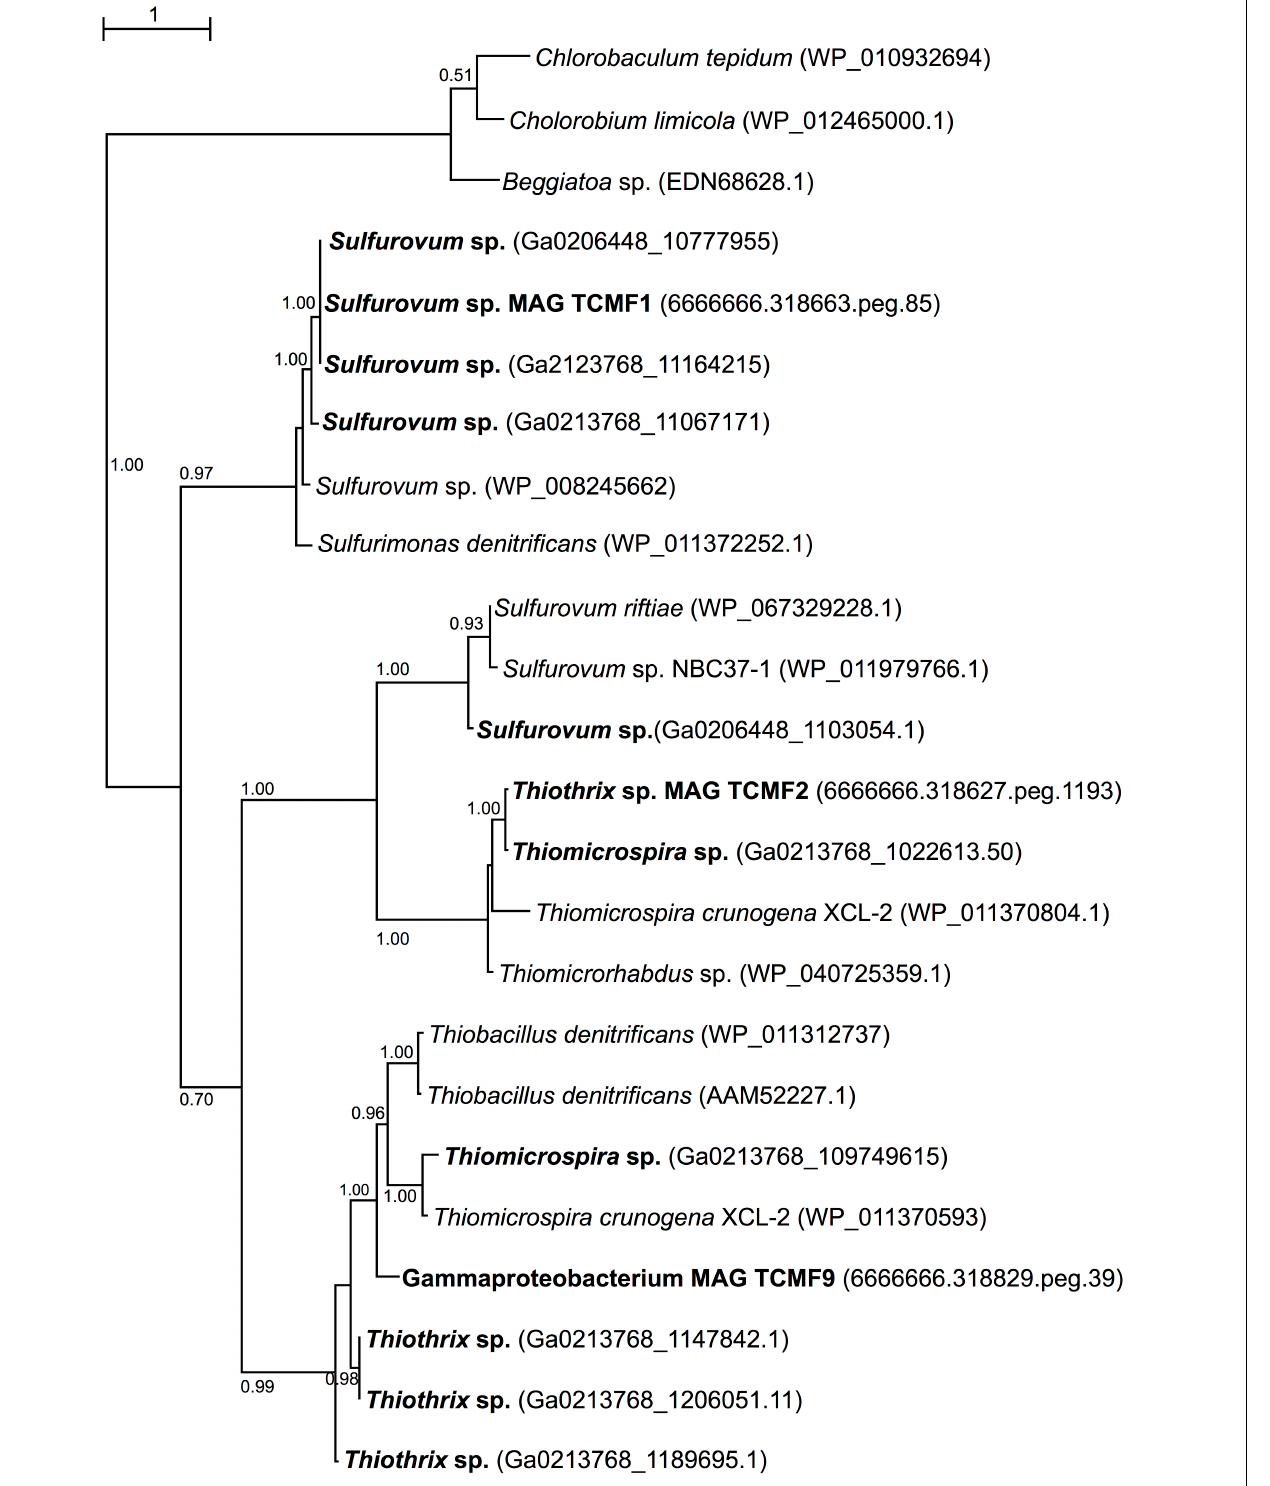
FIGURE 5 | Maximum likelihood phylogenetic tree showing the position of the sulfide quinone oxireductase amino acid sequences, SQR, obtained in this study (indicated in boldface). Closely related sequences were obtained from GenBank. Approximate likelihood ratio test (aLRT) values for branch support are indicated. Bar, 1% estimated